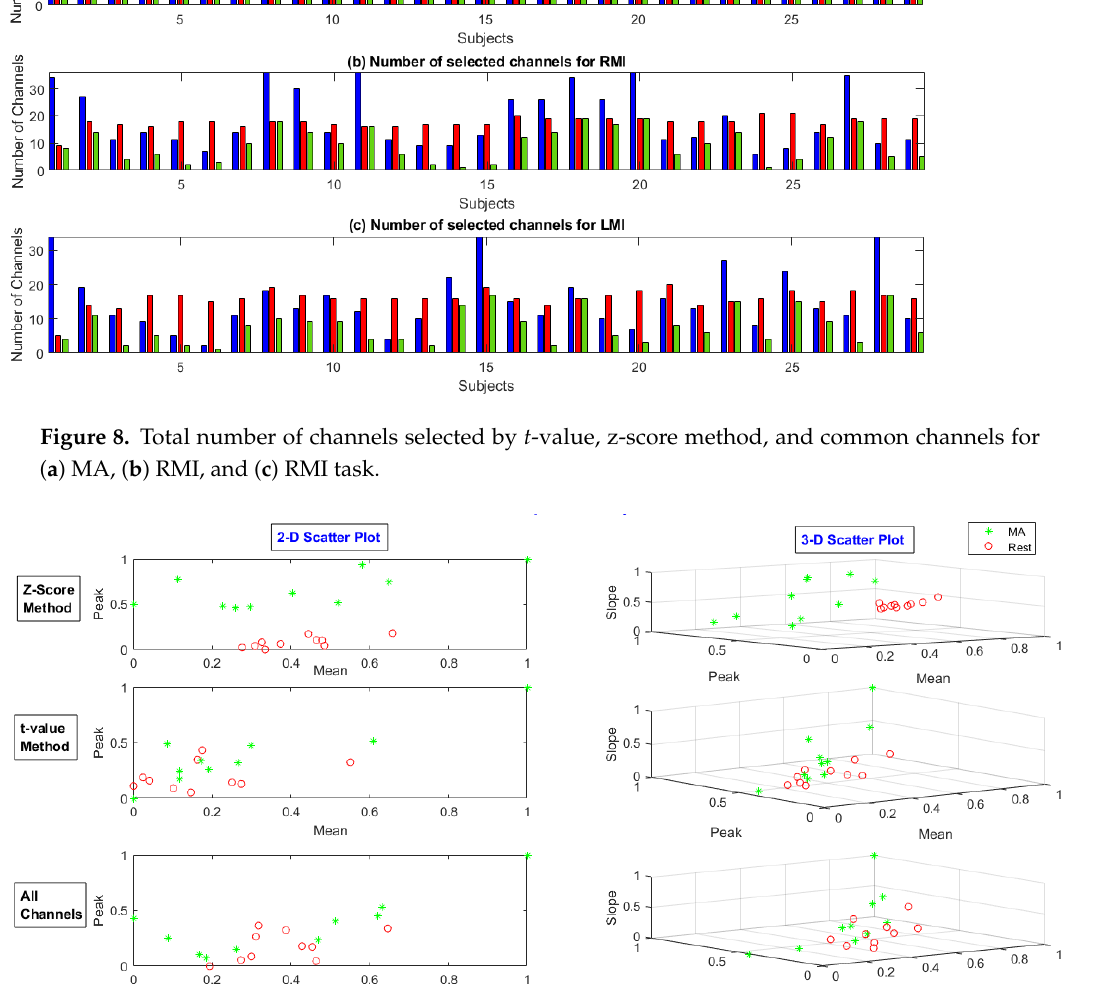
Figure 10. Feature scatter plot of the t -value-method-selected channels’ data, z-score-method-selected channels’ data, and all channels’ data for LMI task.